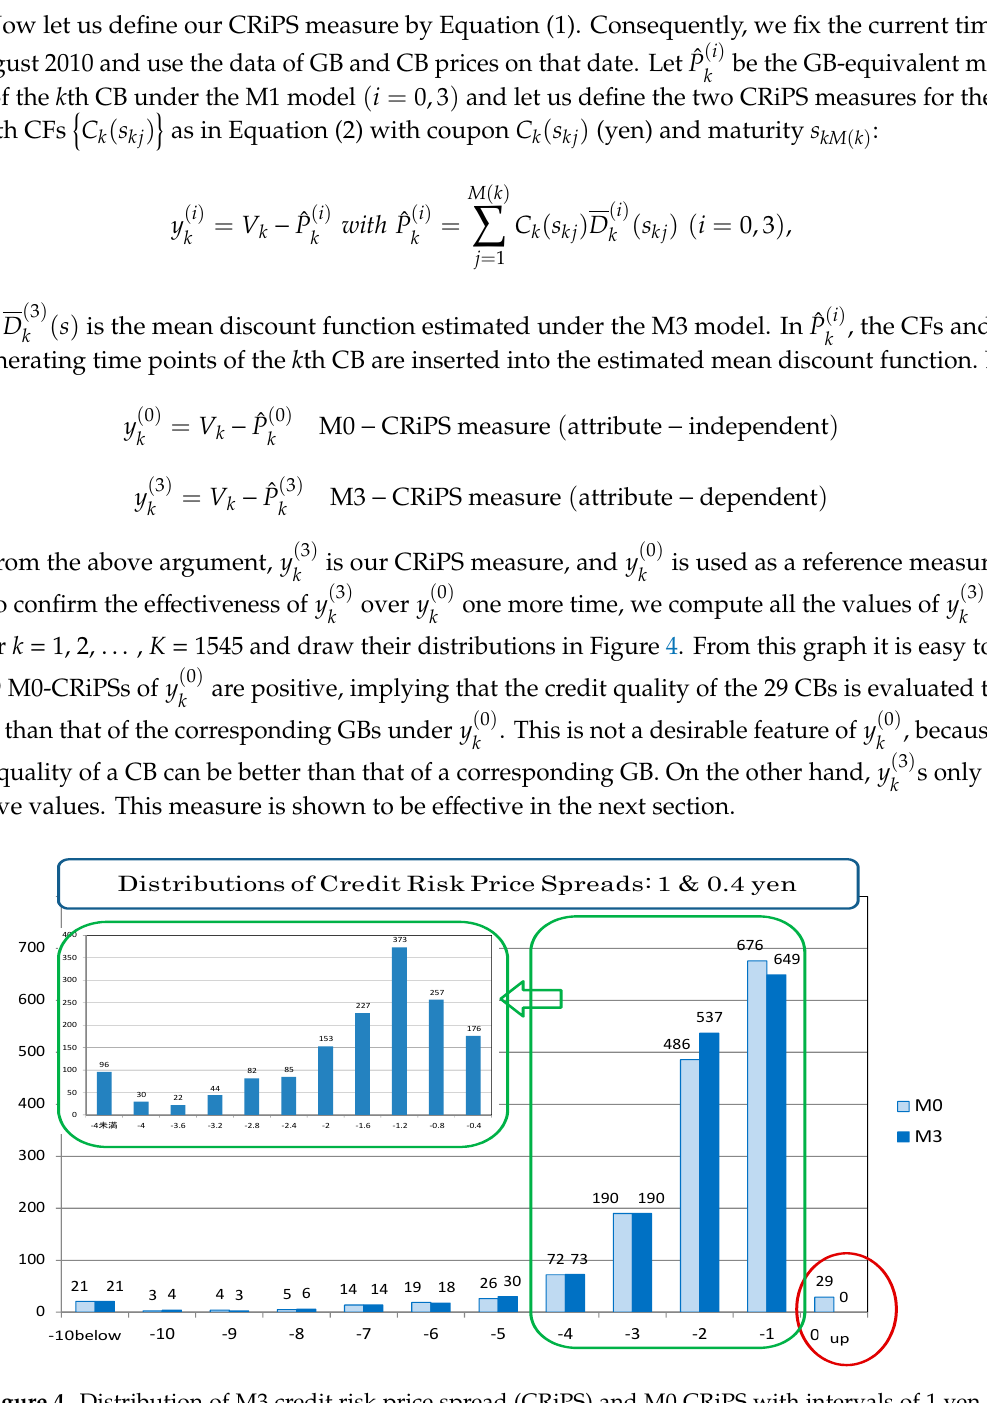
Figure 4. Distribution of M3 credit risk price spread (CRiPS) and M0 CRiPS with intervals of 1 yen split (lower graph) and M3 CRiPS with intervals of 0.4 yen split (upper graph).